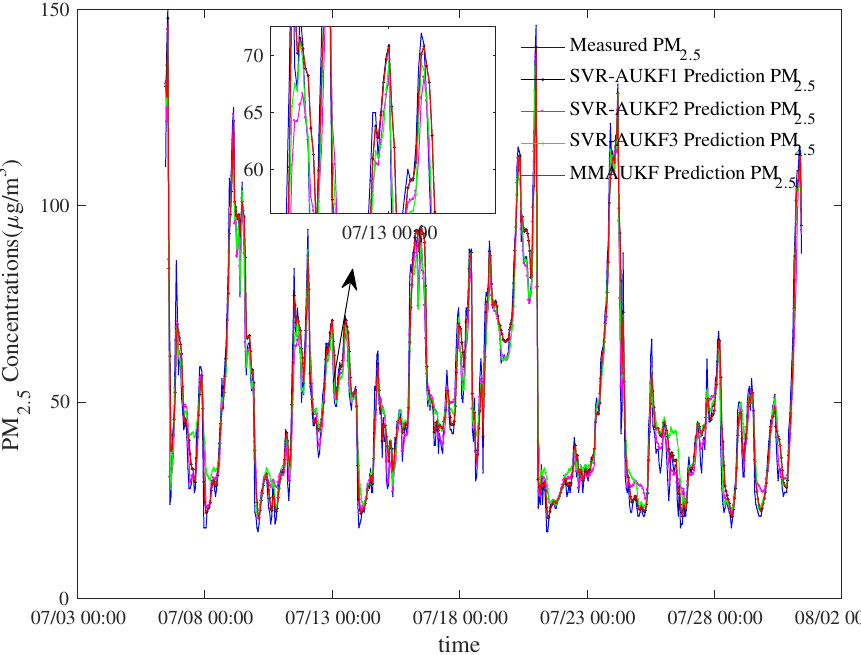
Figure 13. The comparison results of the proposed MMAUKF method and three single SVR- AUKF methods.